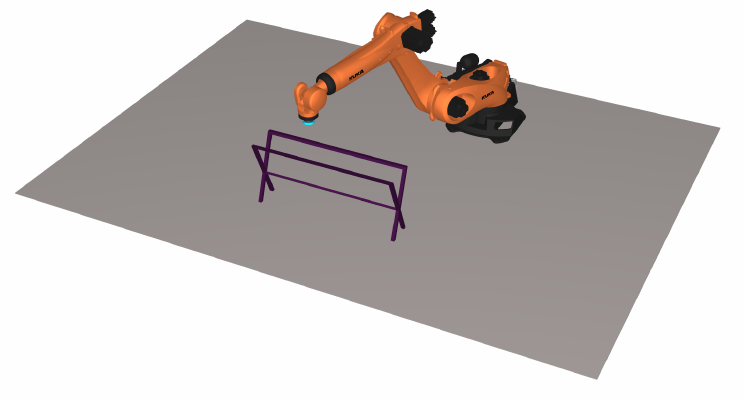
Figure 15. The grinding platform.